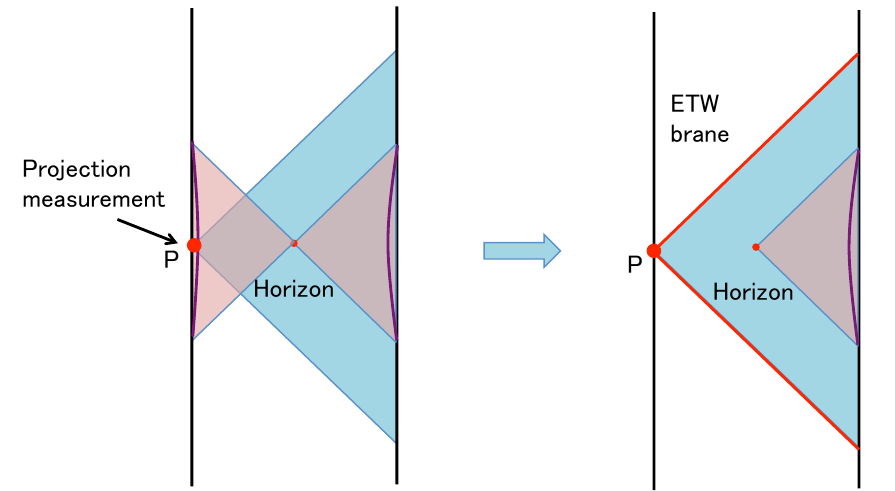
Figure 3 . The gravity interpretation of the thermo(cid:12)eld double states and the projection on them. Measurements create a shock wave which propagates along the red